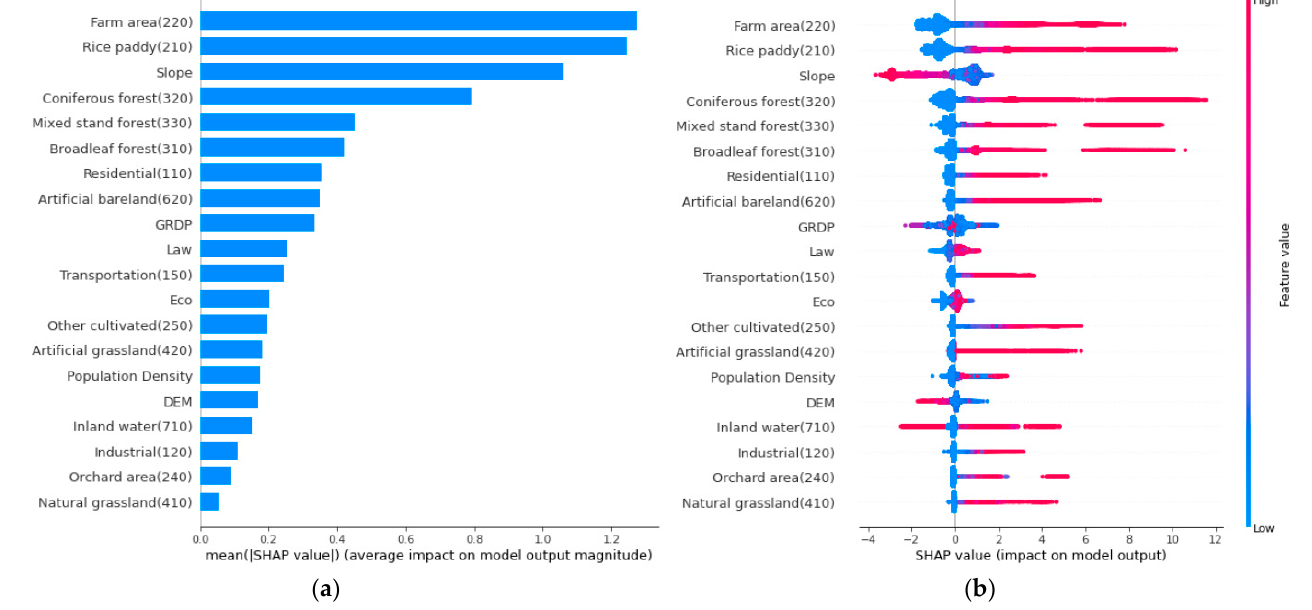
Figure 7. ( a ) Relative importance and ( b ) direction of SHAP values (50 m buffer